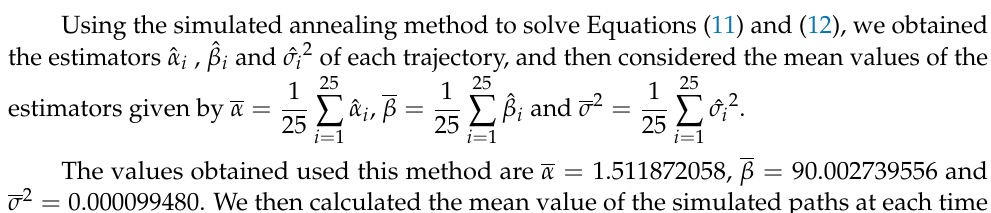
Figure 1. Simulated sample paths vs. the Estimated Trend Function (ETF) for α = 1.5, β = 90 σ =